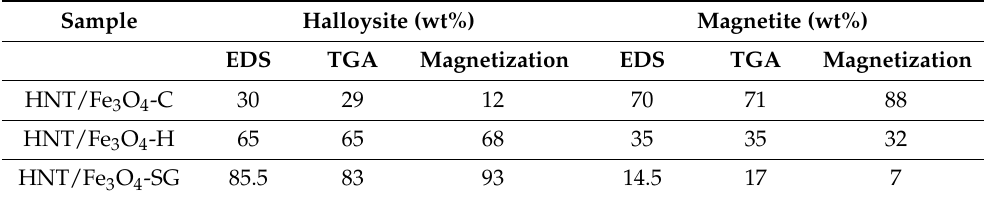
Table 2. Halloysite and magnetite weight percentages evaluated by EDS, TGA, and magnetization data. Sample